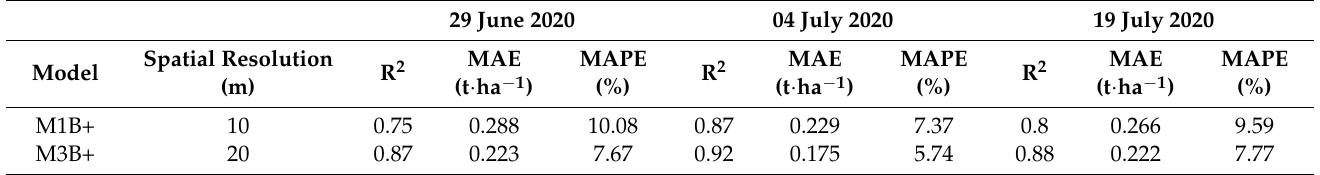
Table 5. Bomba best model evaluation for each date and spatial resolution with training